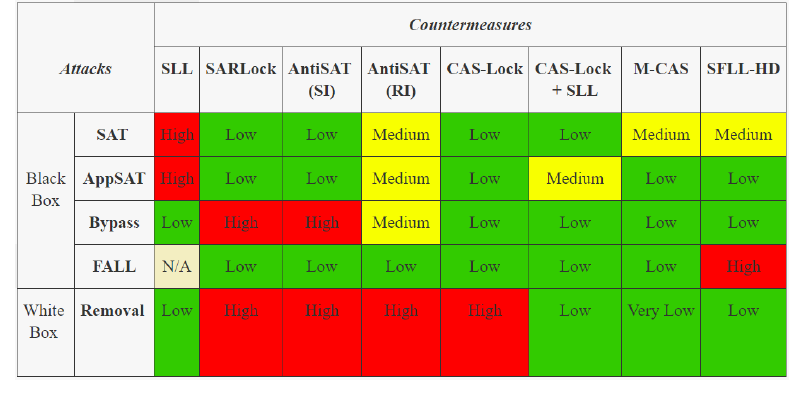
Figure 16: Model Count (i.e., number of incorrect input patterns in the original circuit) vs SAT Iteration for apex2 Logic Cone with N = 10. Table 2: A comparison of various logic locking techniques, attacks and countermeasures. ‘Low’ means that the attack is not successful on the countermeasure i.e., it is reduced to brute force in the input or key length, or is inapplicable, ‘Medium’ implies that the attack works with limited success, while ‘High’ implies that the countermeasure is extremely vulnerable to the